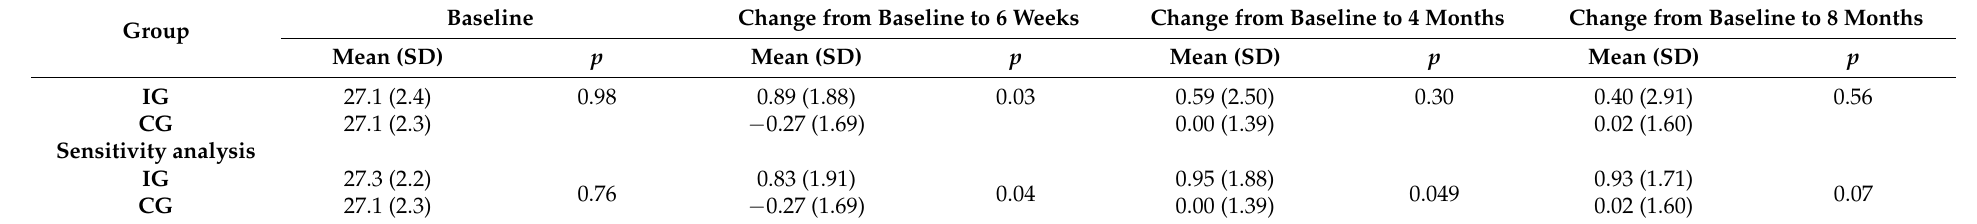
Table 6. Mean change in MNA total scores by randomisation